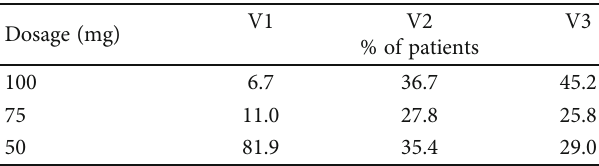
Figure 4: Number of patients satis fi ed with sildena fi l-ODF at V2 and V3. V=Visit. Table 3: Percentage of patients assuming 100, 75, or 50 mg of sildena fi l-ODF at the di ff erent